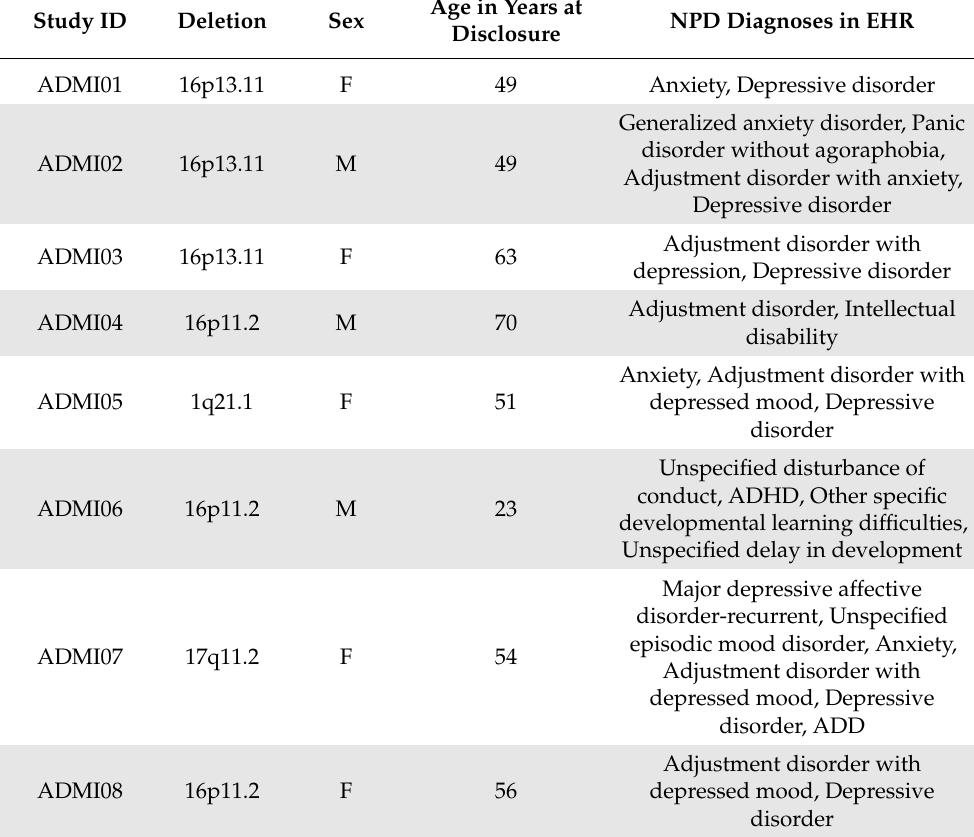
Table 1. Adult participant demographics and NPD diagnoses from the